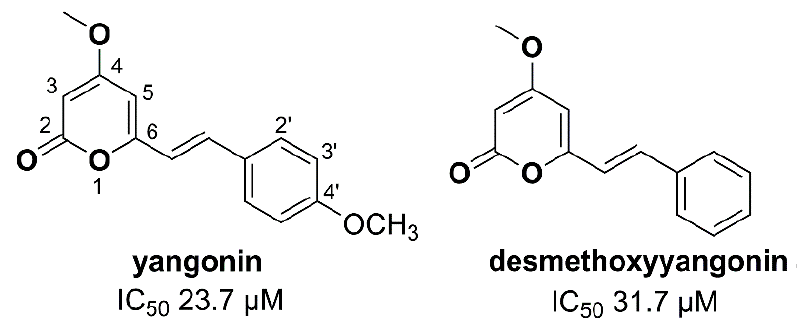
Figure 1. Structures of the natural products, yangonin and desmethoxyyangonin, and their activities against Haemonchus contortus in the larval development assay (see [7]).